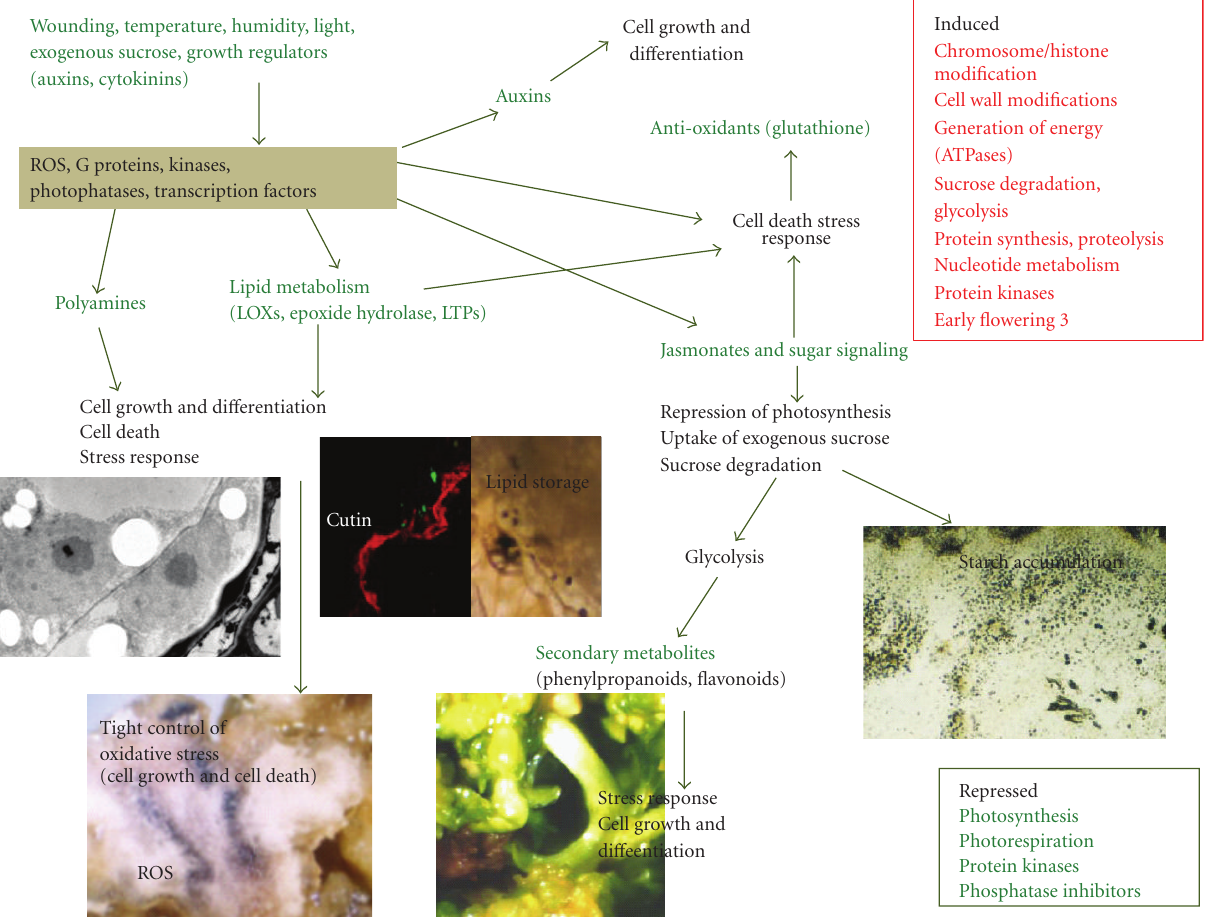
Figure 3: Main pathways leading to formation of hop organogenic cultures . Abiotic factors such as light, wounding, sucrose and auxins induce the early expression of MAPKs. Signaling processes still not fully elucidated are responsible for inducing a stress response in which lipoxygenases, jasmonates, and polyamines as well as an increase in glutathione levels play an important role. Cell division is also induced by MAPKs and involves auxins and polyamines. Sugars and jasmonates may lead to starch accumulation and phenylpropanoid